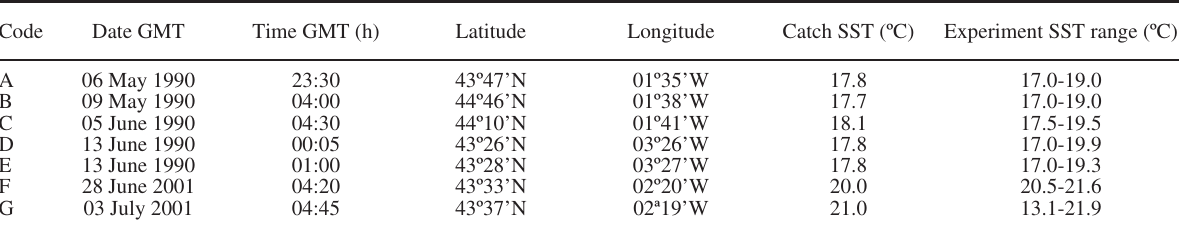
Table 2. – details of catches of the adult samplings for the captivity experiments. A, B, c, d and e correspond to live bait tanks experiments while F and g correspond to the two aquarium experiments. catch sst corresponds to sea surface temperature in centigrade degrees at catch location. experiment sst range is the range of the water temperatures in the tanks during the experiments in centigrade degrees (for live bait tanks this is the sst measured in the areas and on the dates of the